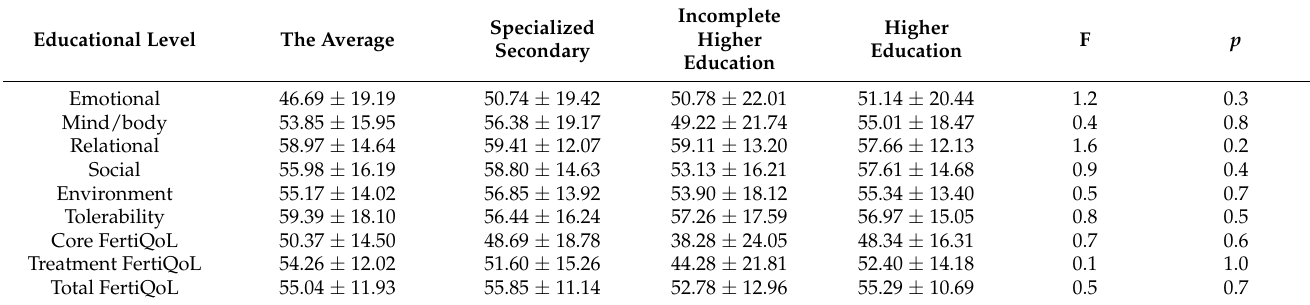
Table 7. The relationship between FertiQoL and the education levels.